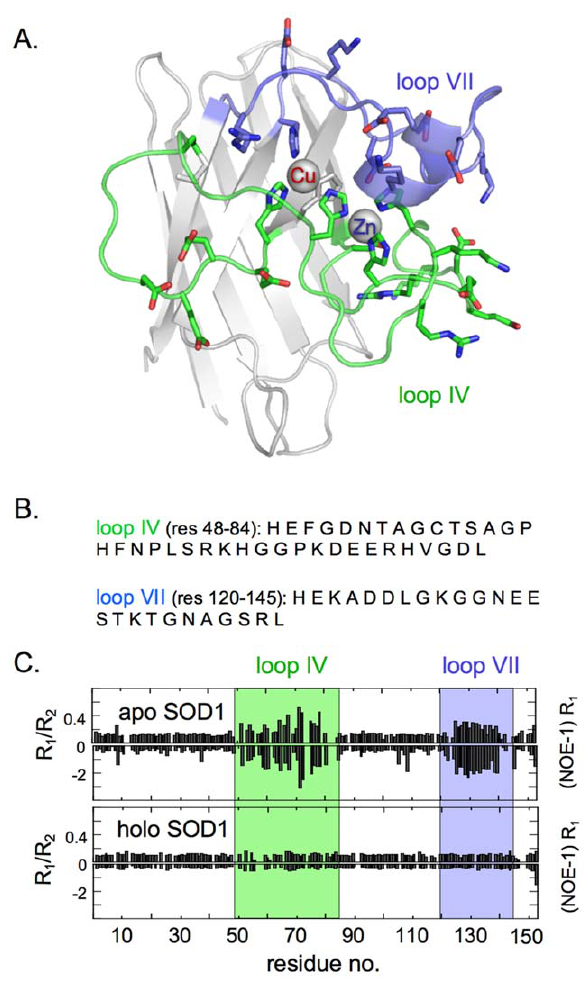
Figure 4. Loss of Cu 1 + /2 + and Zn 2 + ions leads to increased backbone dynamics of the active-site loops IV and VII. The backbone dynamics of monomeric apo- and holoSOD1 evaluated by NMR relaxation experiments. ( A ) Structural representation of the SOD1 monomer showing the regions of increased dynamic motions in the apo state. ( B ) Amino-acid sequence of loops IV and VII. ( C ) Increased dynamics in the intermediate time scale is indicated by increased values of R 1 /R 2 and increased fast dynamics as increased negative values of (NOE-1)R 1 . In the apoSOD1 monomer, the regions of loops IV and VII show increased dynamics [31], whereas in the metallated monomer [71] the loops are as fixed as the rest of the protein. Figure outline adapted from Nordlund et al.